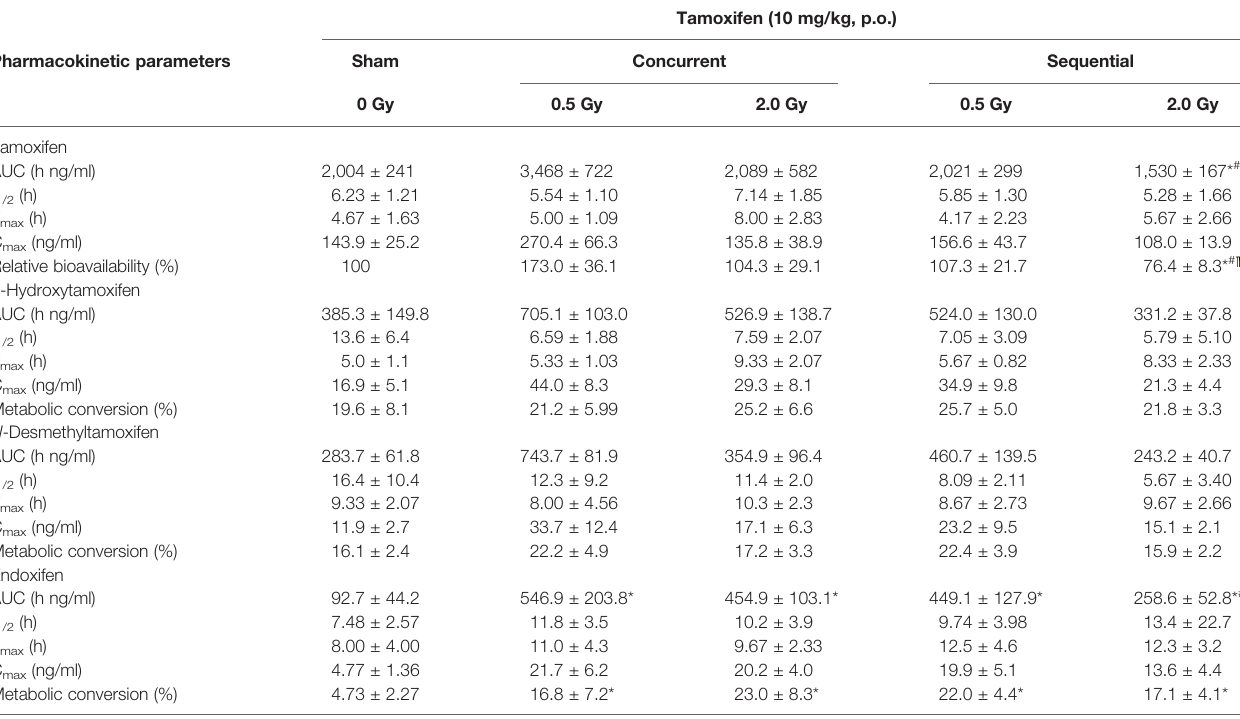
TABLE 1 | The parameters of pharmacokinetic in tamoxifen, 4-hydroxytamoxifen, N -desmethyltamoxifen, and endoxifen for rats treated with tamoxifen (10 mg/kg, p.o.) concurrent or sequential with irradiation 0.5 Gy (RT 0.5Gy ) and 2 Gy (RT 2.0Gy ).